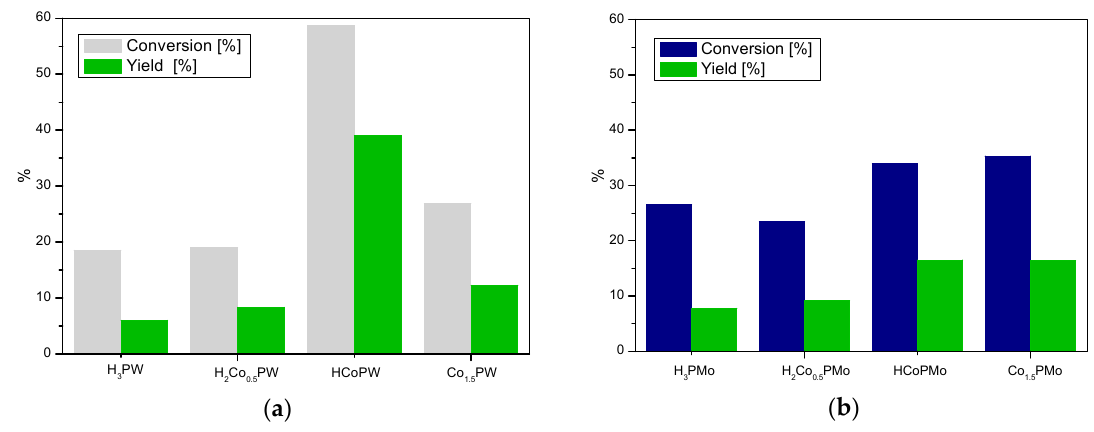
Figure 2. The BV oxidation of cyclohexanone with ( a ) cobalt tungstophosphate catalysts and ( b ) cobalt molybdophosphate catalysts.